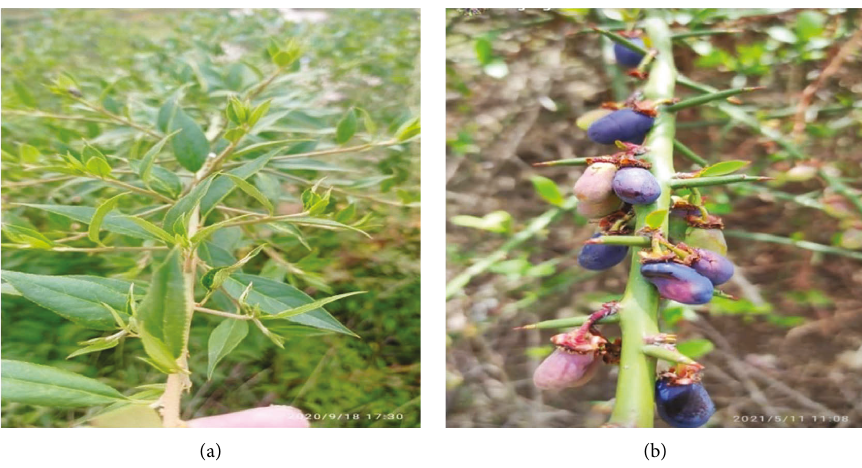
Figure 1: P. utilis plant: (a) Fresh leaf; (b) Ripen